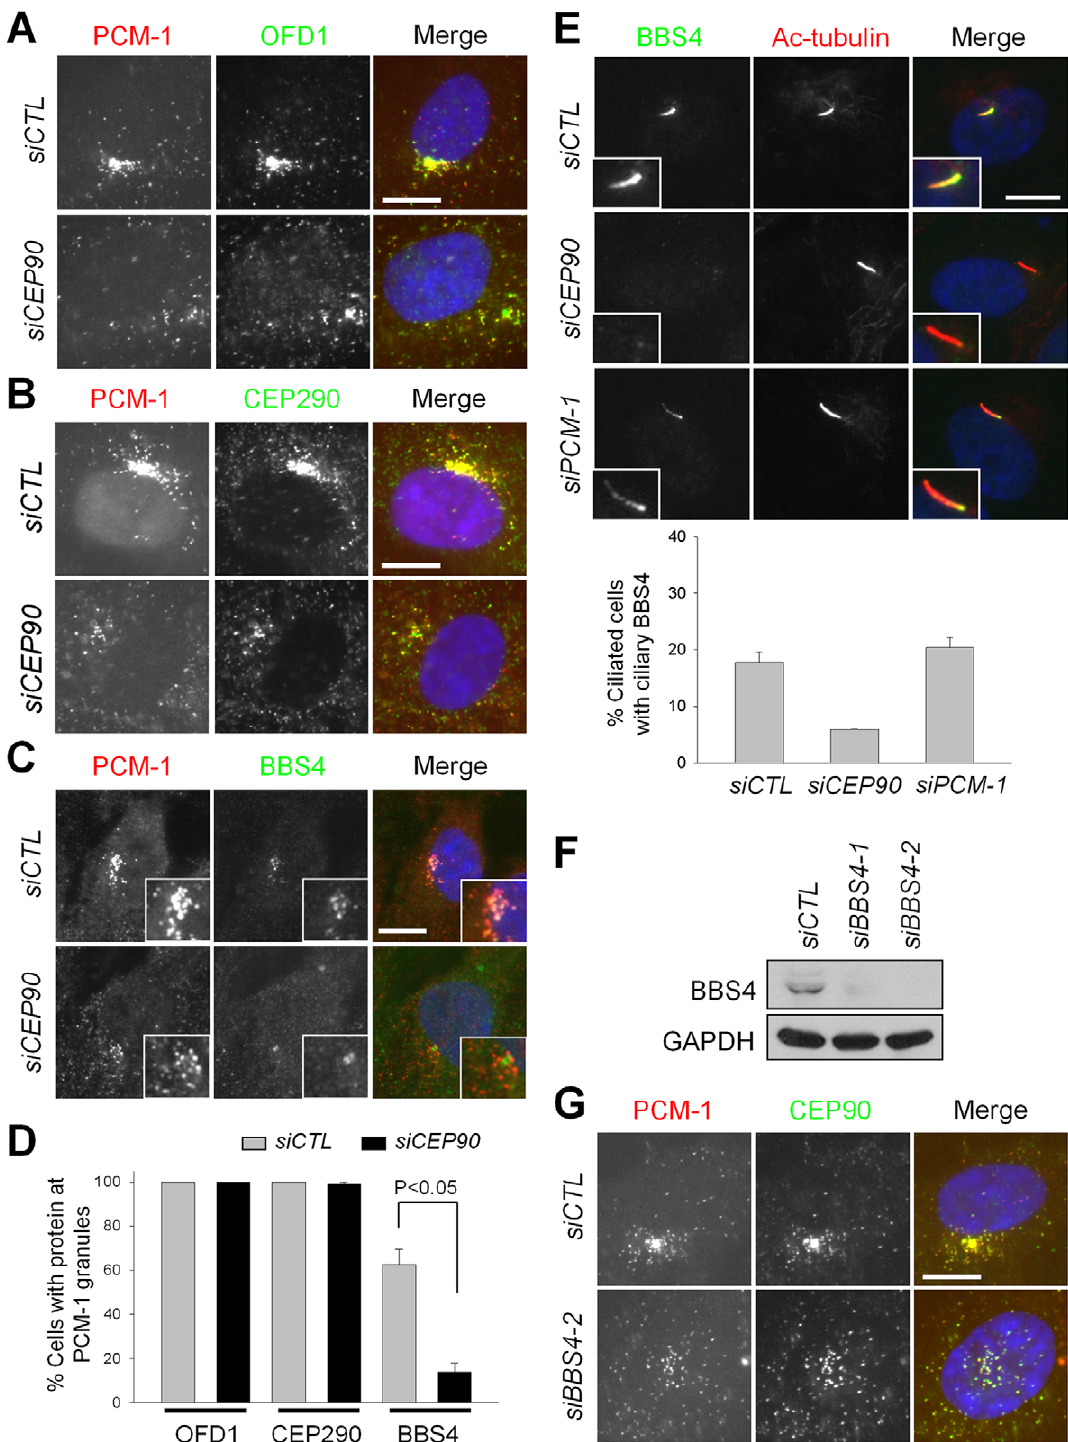
Figure 2. CEP90 is critical for BBS4 localization at centriolar satellites. (A–B) The CEP90-depleted RPE-1 cells were co-immunostained with the antibodies specific to OFD1 (A) or CEP290 (B), along with PCM-1. (C) The cells were co-immunostained for PCM-1 and BBS4. Insets are magnified views of the PCM-1 granules. (D) The number of cells with OFD1, CE290 and BBS4 at the PCM-1-granules was counted. Over 200 cells per experimental group were analyzed in 2 independent experiments. (E) Cilia formation was induced by serum starvation for 24 hours. The cells were immunostained with antibodies specific to BBS4 and acetylated-tubulin. The number of cells with BBS4 at their cilia counted with over 300 ciliated cells in 3 independent experiments. The graphs show the mean values and standard errors (D, E). (F) Depletion of BBS4 with two specific siRNAs in RPE-1 cells. GAPDH is a loading control. (G) PCM-1 and CEP90 were co-immunostained after BBS4 depletion with siBBS4-2. Scale bar, 10 m m.